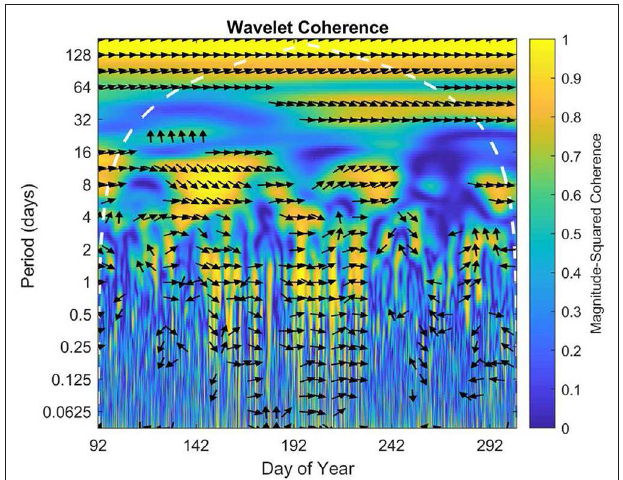
FIGURE 8 | Wavelet coherence for growing season 2016. The x axis represents time, while y axis represents frequency. The direction of each arrow represents phase lag of half-hourly NEE of the open fen with respect to the sheltered fen on a unit circle. Phase arrows pointing right mean data is in-phase. Left is anti-phase. Down means the open fen leads by 90 ◦ . Up means the sheltered fen leads by 90 ◦ . The white dashed line is the cone of influence, which eliminates data potentially impacted by edge-effect artifacts. Yellow indicates high coherence of data, while blue indicates low coherence.